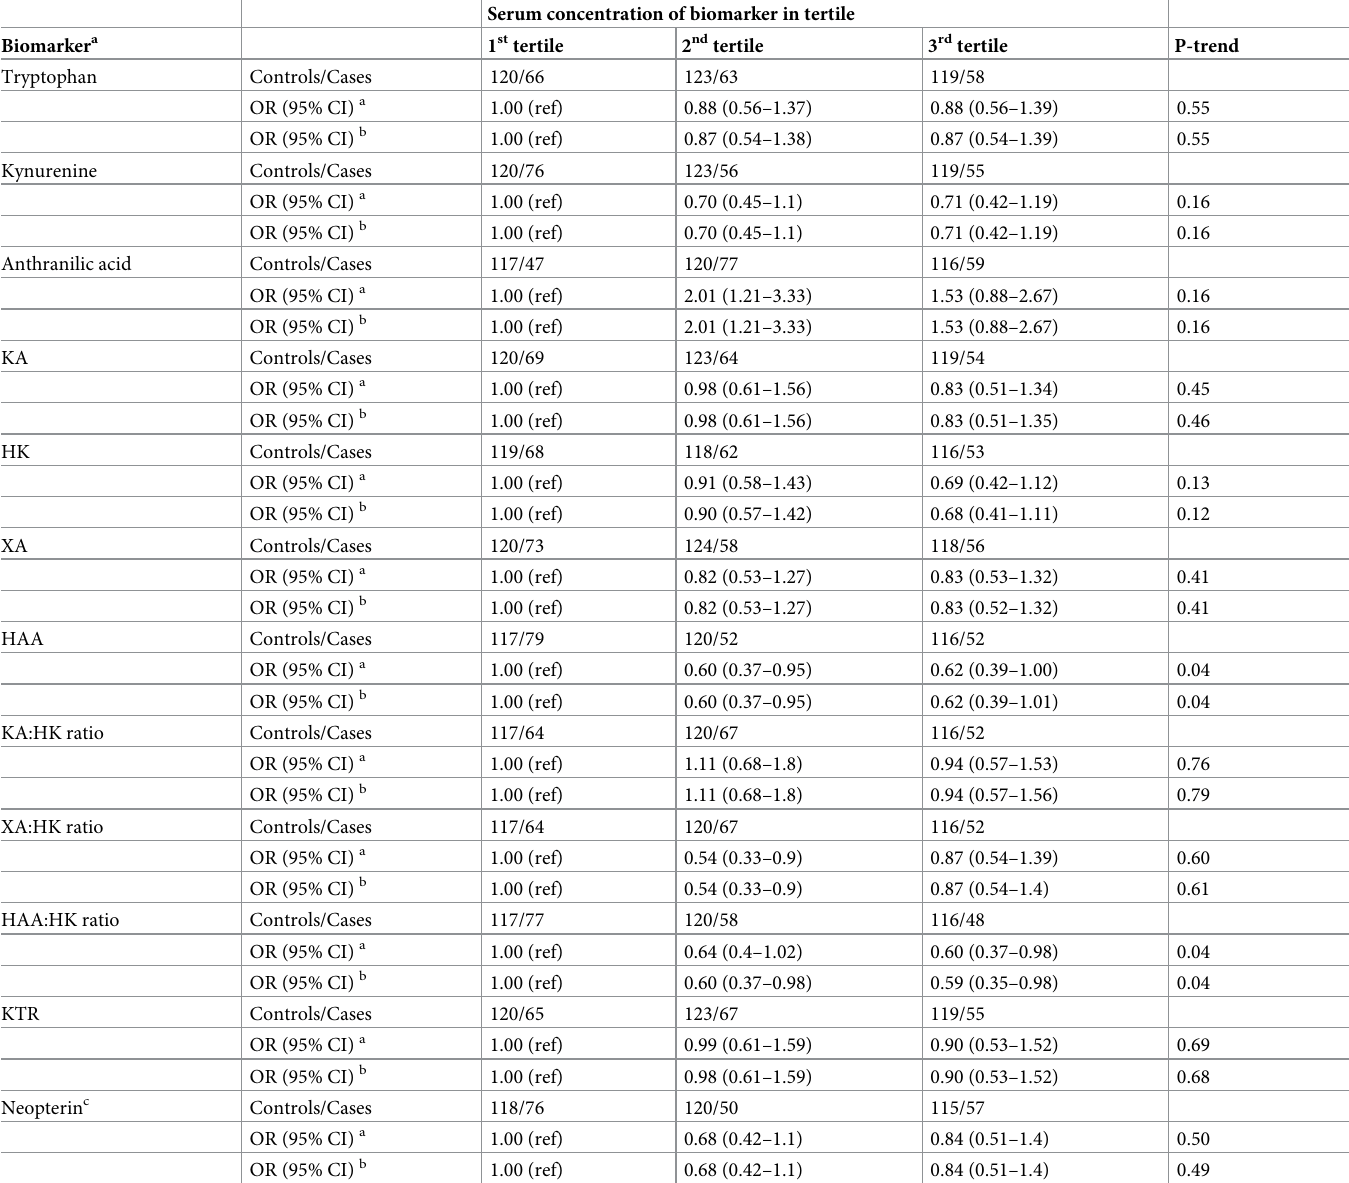
Table 4. Associations of tryptophan, kynurenines, and neopterin with pancreatic cancer risk in both Shanghai and Singapore cohorts combined (187 cases and 362 controls). Serum concentration of biomarker in